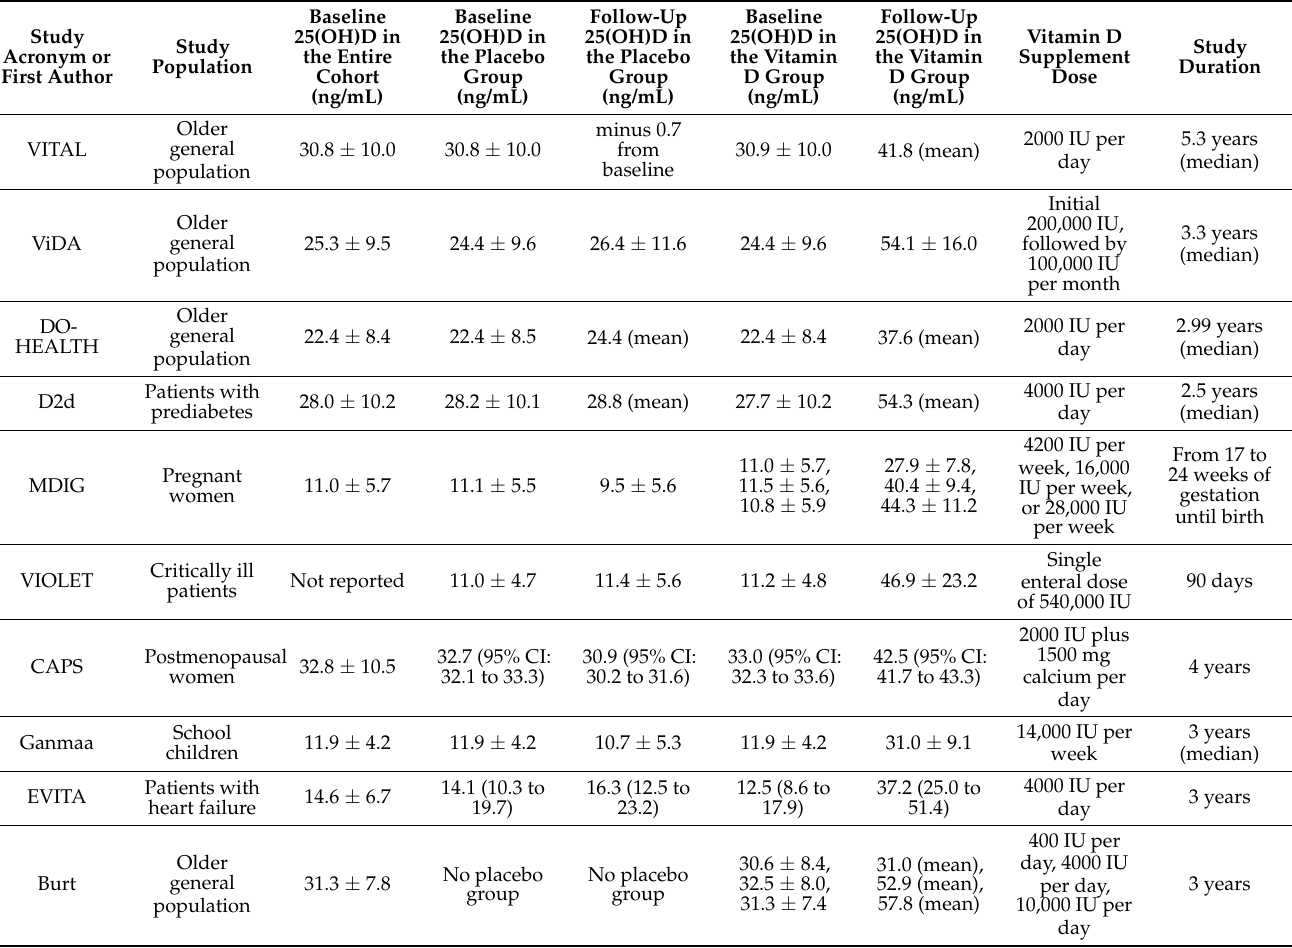
Table 1. Baseline and follow-up 25(OH)D concentrations and vitamin D dosing regimens of selected recent large vitamin D